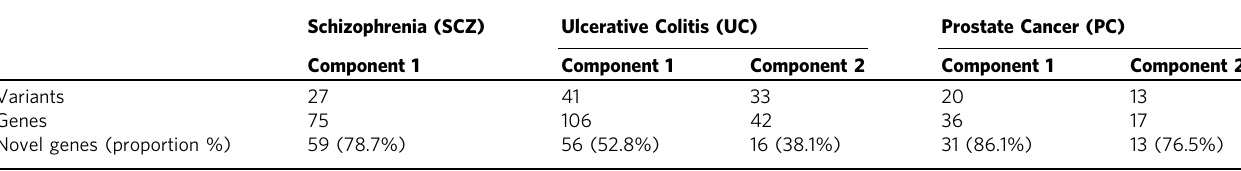
Table 2 The number of variants, genes and novel genes selected by ARCHIE for each the signi fi cant components for the analysis of SCZ, UC and